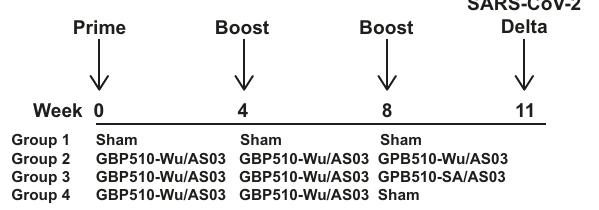
Fig. 1 Vaccination and challenge schedule. Schematic of vaccine groups with the timing of immunization and challenge